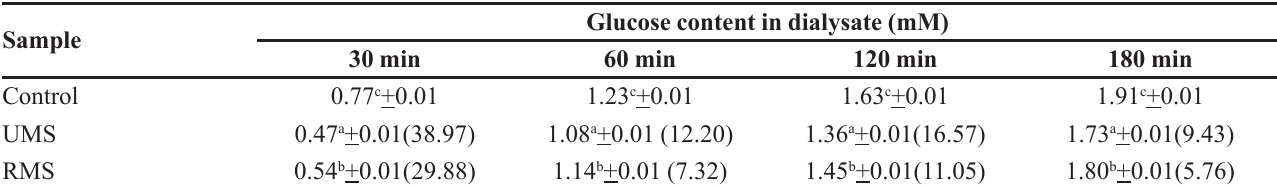
TABLE I - Effect of selected samples on glucose diffusion and glucose dialysis retardation index Sample